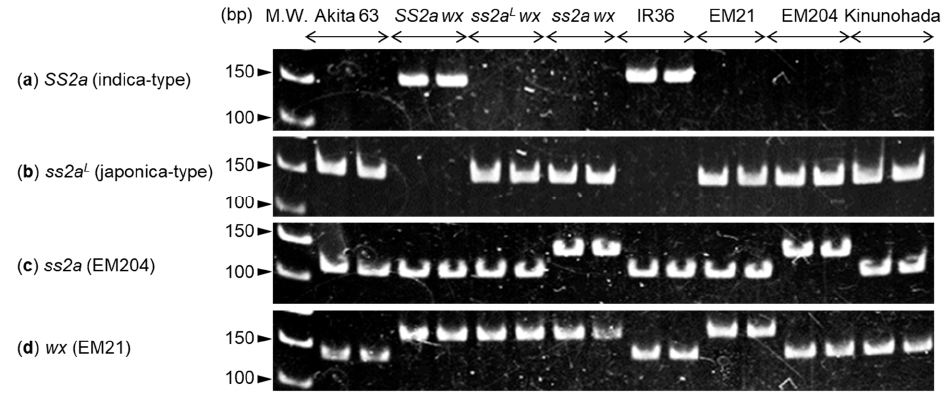
Figure 1. Analysis of nucleotide polymorphisms and mutation sites in starch synthase ( SS ) IIa and waxy ( Wx ) genes. ( a , b ) Genotyping the high activity-type SS2a allele derived from indica rice ( a ) and low activity-type ss2a L allele derived from japonica rice ( b ) based on nucleotide polymorphisms in the first exon of the SSIIa gene. ( c ) Identification of the ss2a allele derived from EM204 based on the mutation